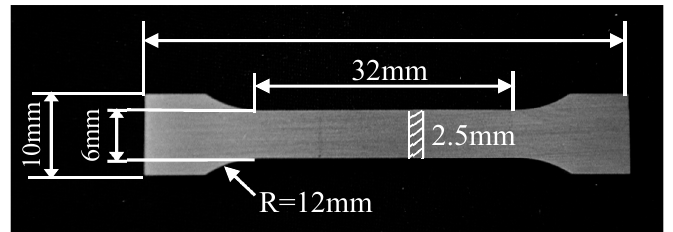
Figure 2. The schematic diagram of tensile specimen.